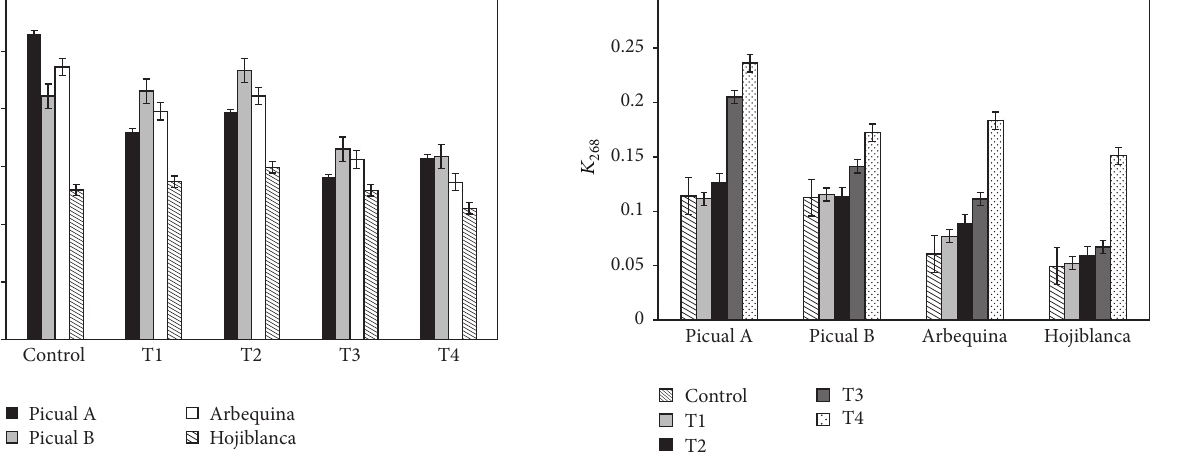
Figure 2: Variation of 𝐾 268 with the